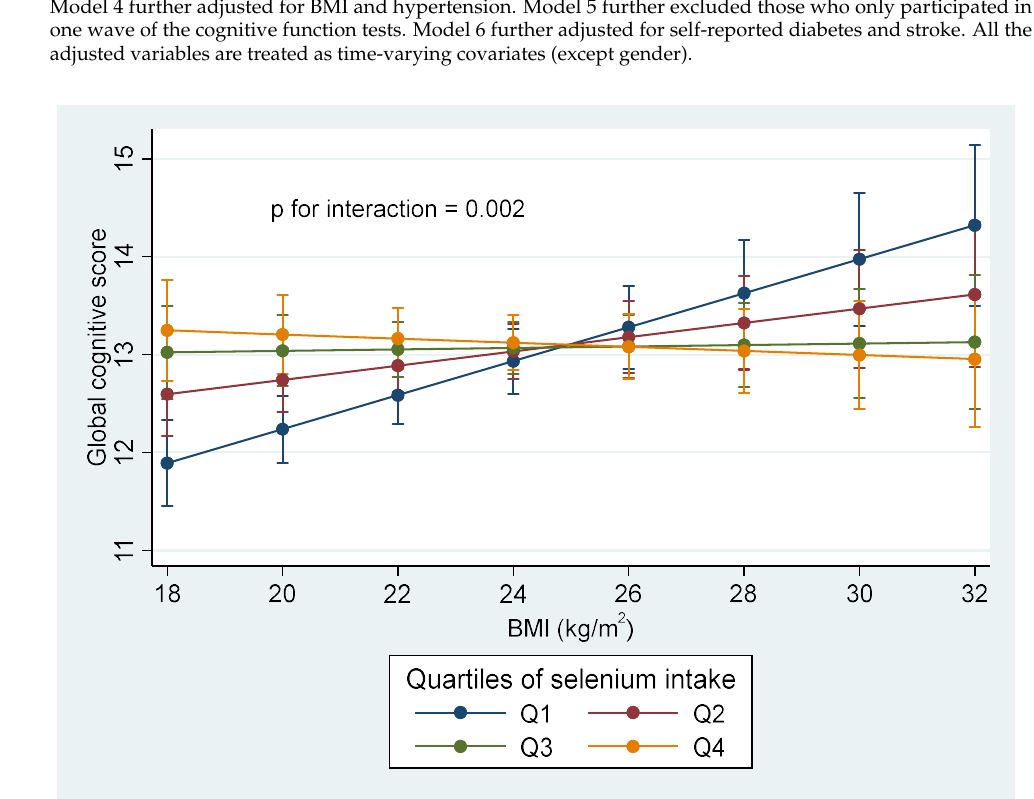
Figure 2. Interaction between selenium intake and BMI in relation to cognitive function score. Values are means (95% CI) derived by using the margins command in Stata after running a mixed linear model adjusted for age, gender, intake of energy and fat, education, urbanicity, smoking, alcohol drinking, physical activity, and fruit and vegetable intake. p for interaction between selenium intake and BMI was 0.002. An ordinal value (1, 2, 3, 4) was assigned to reflect the quartiles of selenium intake level. Q, quartile.